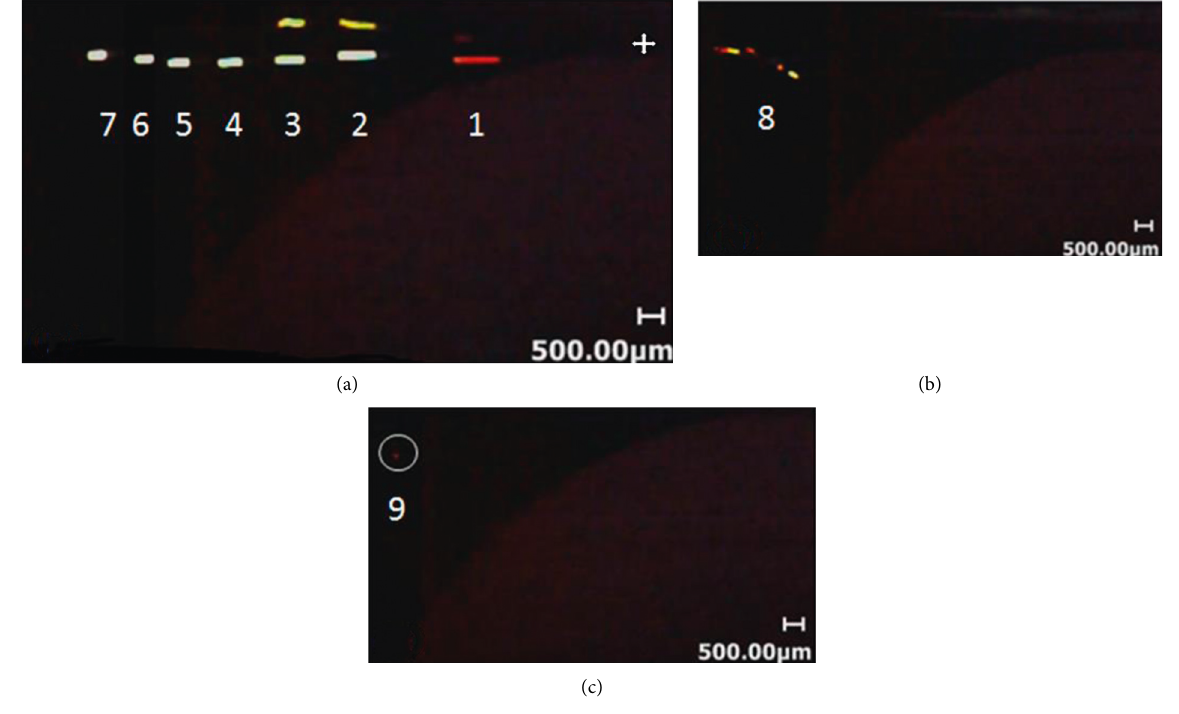
Figure 7: Spark flight paths at speed of 62.8m/s. Table 1: Measurement of the flight trajectory of TC4